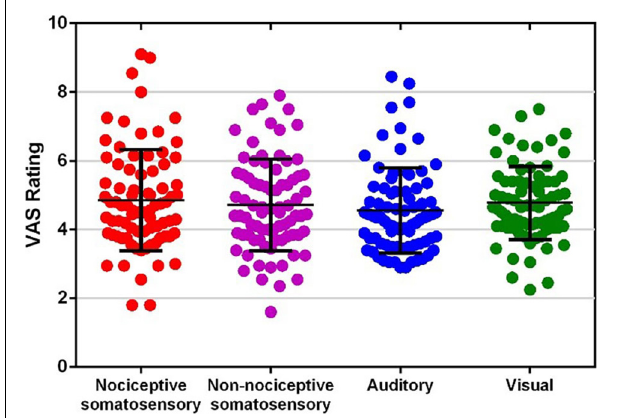
FIGURE 1 | Visual analog scale (VAS) ratings of each type of sensory modality. Each dot represents the average rating of one participant to one type of sensory